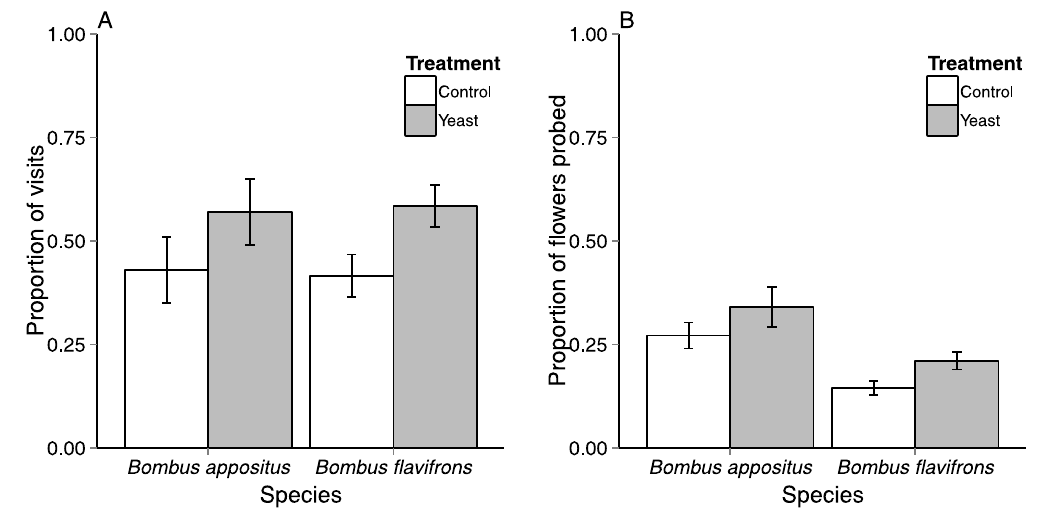
Figure 2. Mean (A) proportion of visits and (B) proportion of flowers probed per foraging bout within an inflorescence for B. appositus and B.flavifrons to control and yeast-treated Delphiniumbarbeyi . Bars represent means + SE.